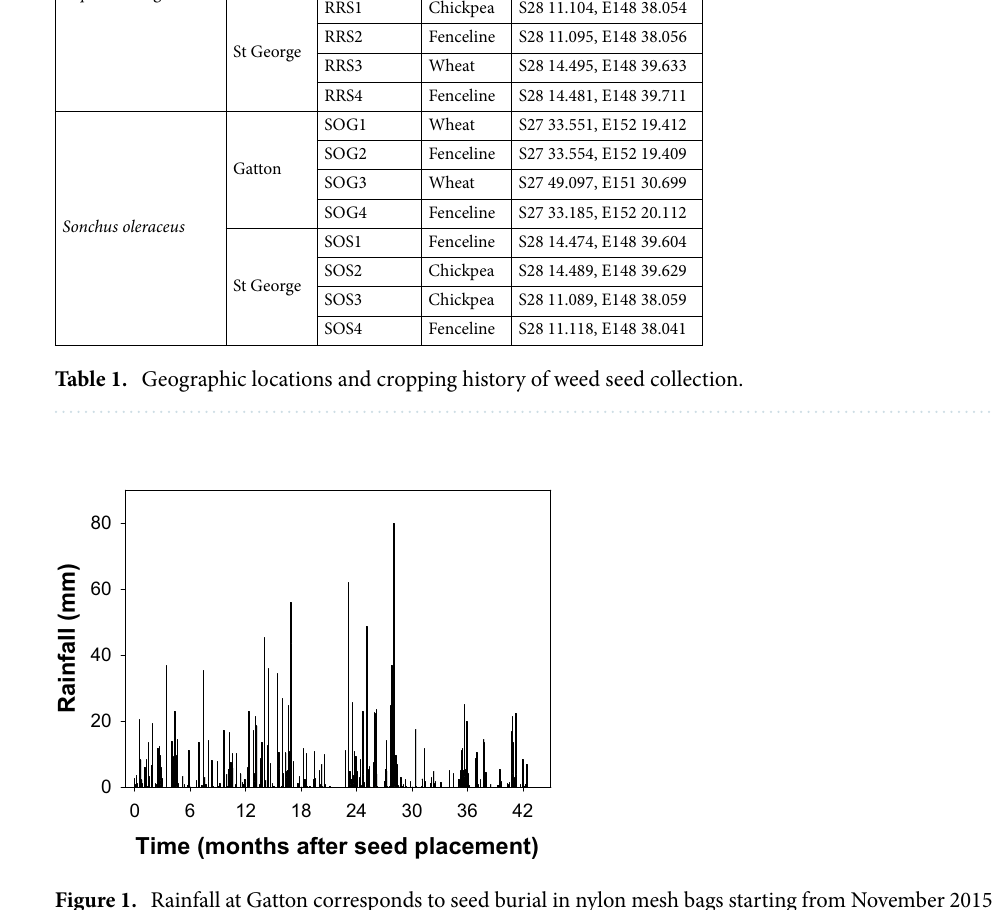
Figure 1. Rainfall at Gatton corresponds to seed burial in nylon mesh bags starting from November 2015 to April